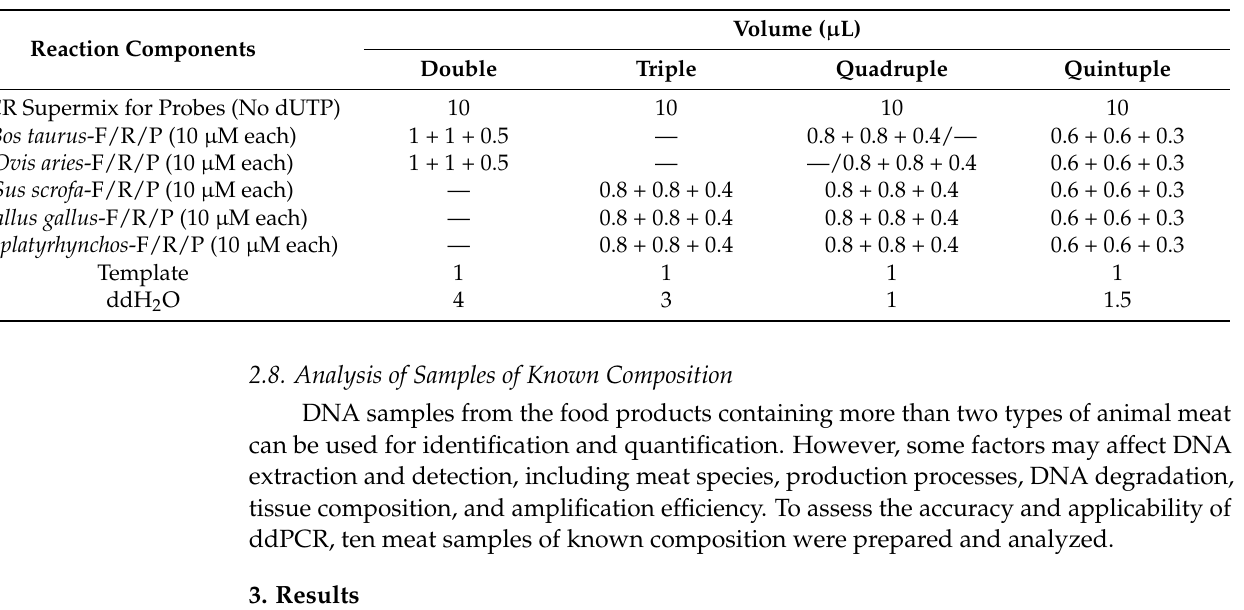
Table 2. Reaction system of ddPCR (20 µ